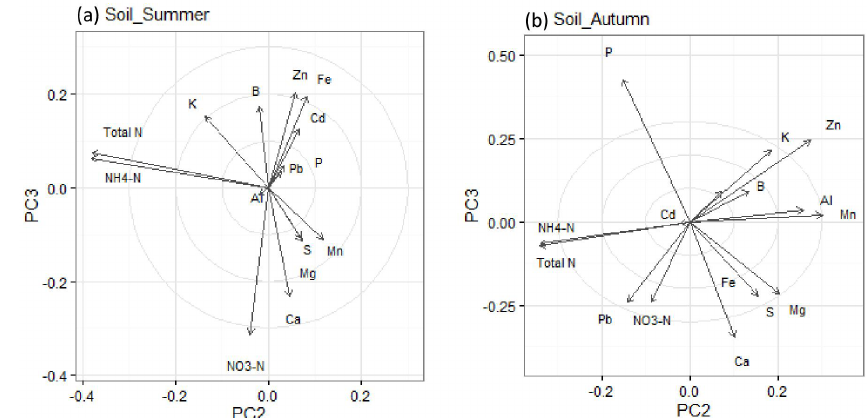
Figure 3. Loading values for principal components 2 and 3 of the chamber soil concentration analysis.